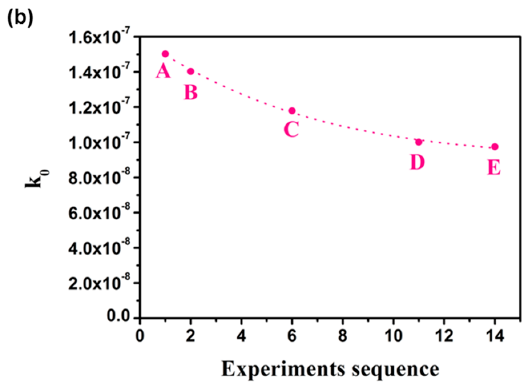
Figure 3. ( a ) Conversion vs. Temperature plot of the reference tests. Experimental data is plotted by dots. Calculated data (Equation (15)) is plotted as solid lines. ( b ) Decrease of the estimated preexponential factor of the reference tests. Catalysts 2018 , 8 , x FOR PEER REVIEW